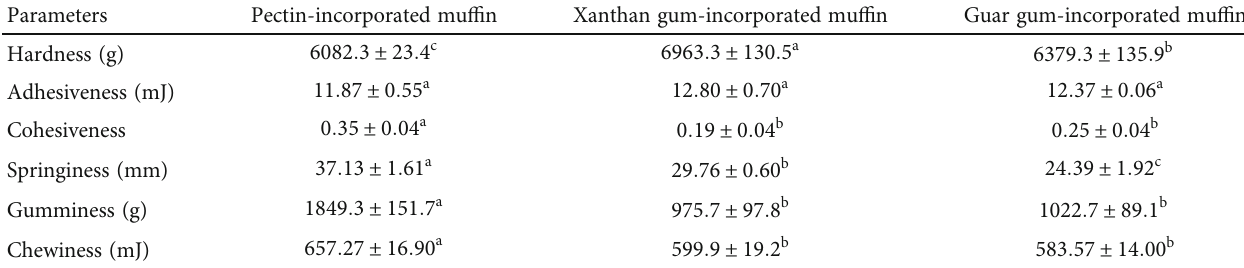
Table 3: Instrumental texture analysis of mu ffi